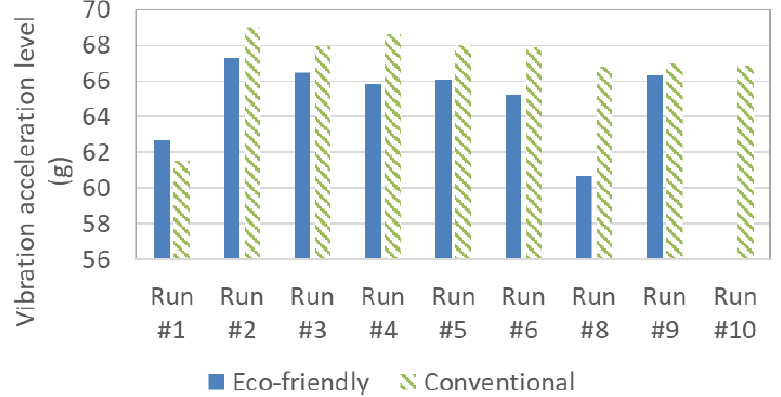
Figure 20. Vibration acceleration level on the tunnel walls based on the 1 / 3 octave band analysis.